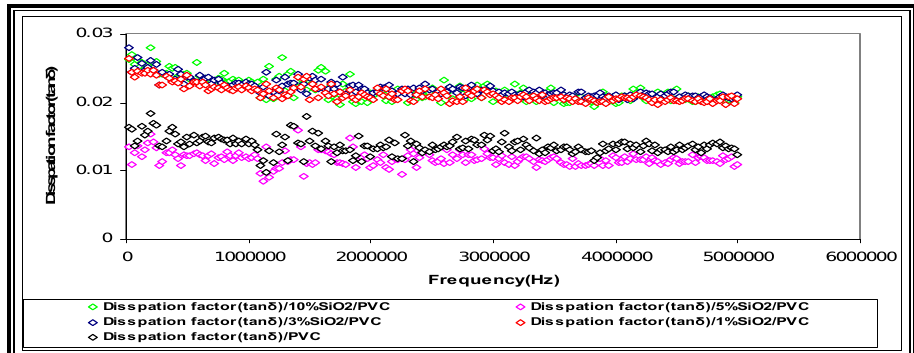
Fig. 14: Frequency dependent dissipation factor of PVC & SiO